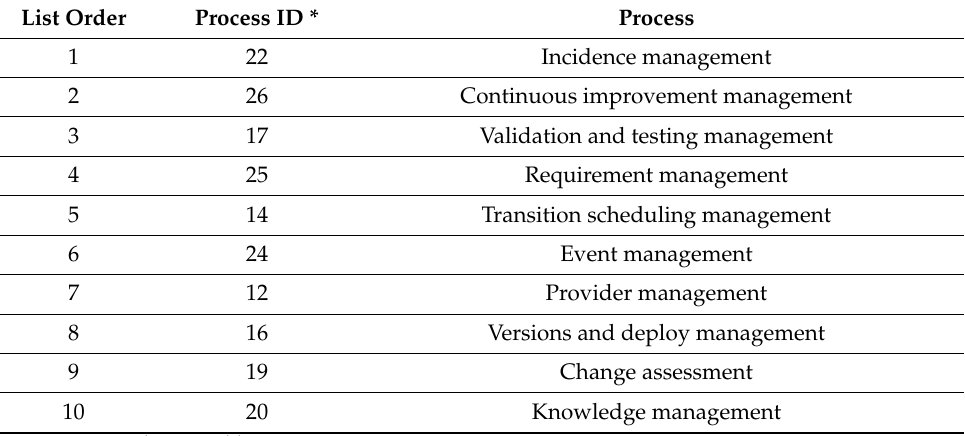
Table 4. Proposal of ordered list of ITIL processes applying the improved methodology. List